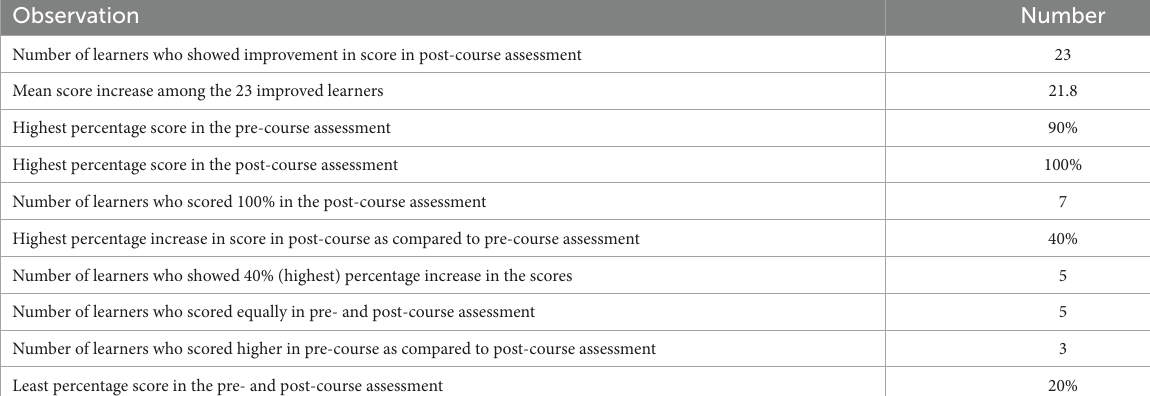
TABLE 4 Evaluation of pre-and post-course assessments.